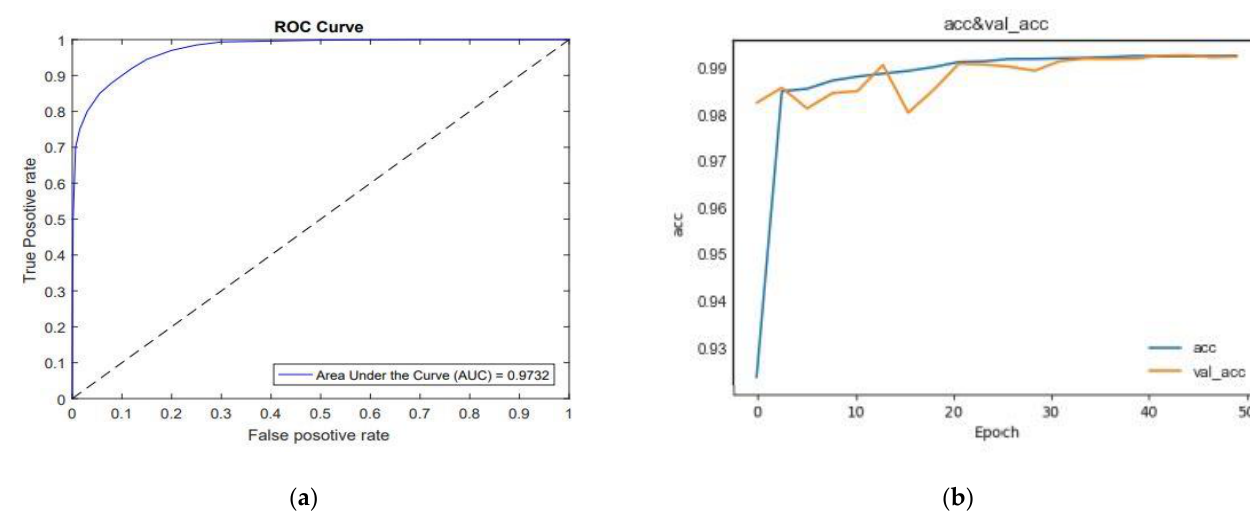
Figure 18. ( a ) . ROC curve of Res BCDU-Net; ( b ) . The accuracy of training and test for Res BCDU-Net. According to Figure 18a, the AUC corresponds to 0.9732 which implies the effective- ness of the proposed model performance. Figure 18b shows that the network converges quickly; on the other hand, it converges after the 35th epoch. We also can see that the accuracy of training increases to over 99% after the 35th epochs. This is a good indicator of appropriate training of the network. In the validation phase, from epoch 0 to 30, it